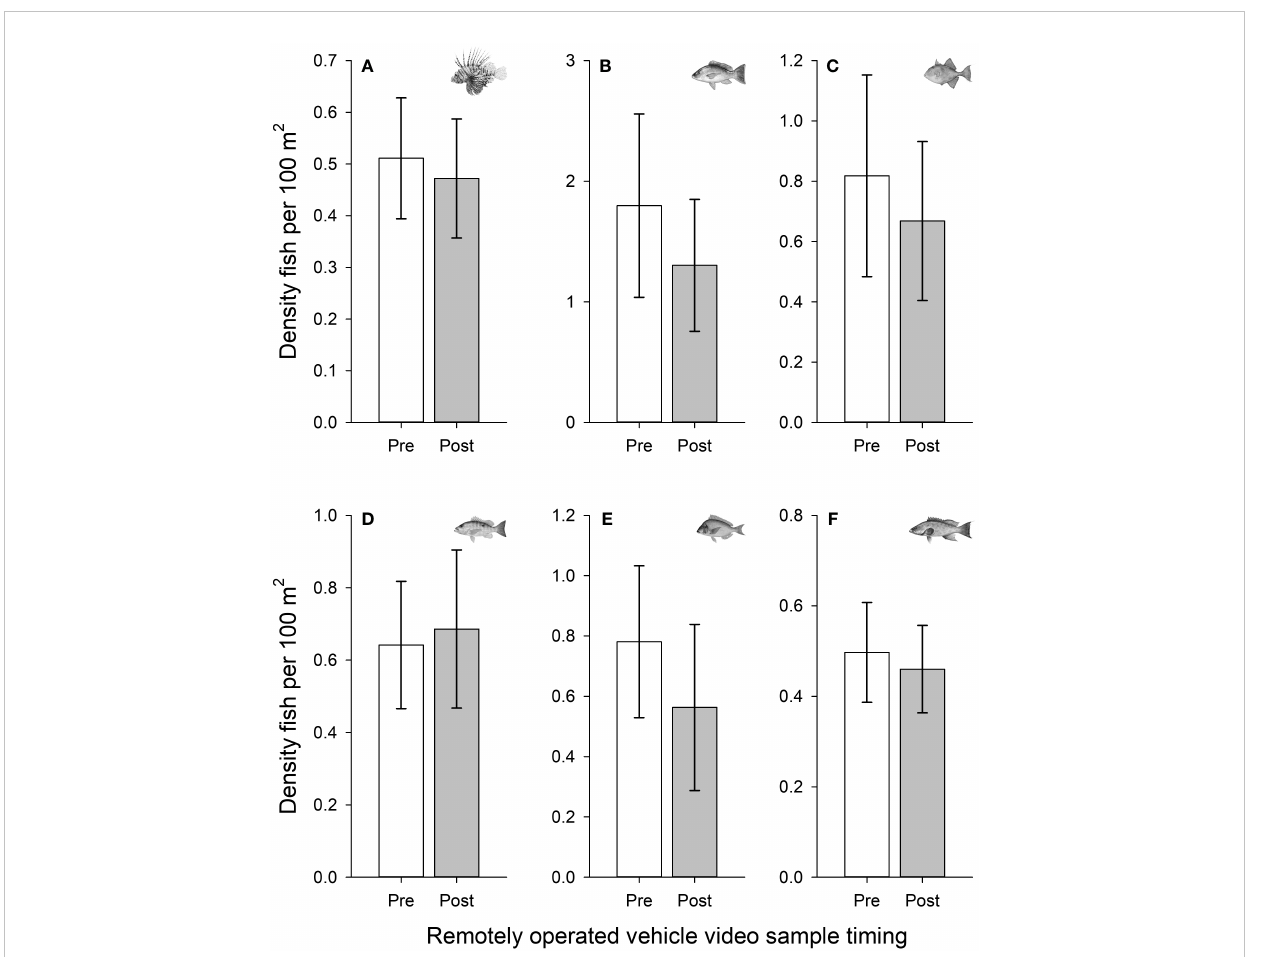
FIGURE 5 Fish densities pre-deployment (pre) and before retrieval (post) of experimental lion fi sh traps. Mean (± 95% CI) densities are shown for (A) lion fi sh, (B) red snapper, (C) gray trigger fi sh, (D) lane snapper, (E) red porgy, and (F) scamp (note scale differences among panels). Densities were estimated via remotely operated vehicle video surveys conducted at 120 trap deployment sites on northeastern Gulf of Mexico mesophotic